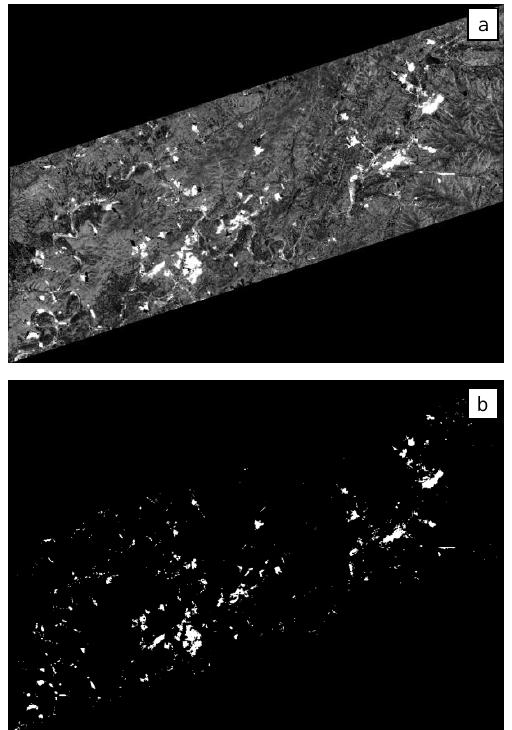
Fig.2 Spectral characteristics of typical features in the study area